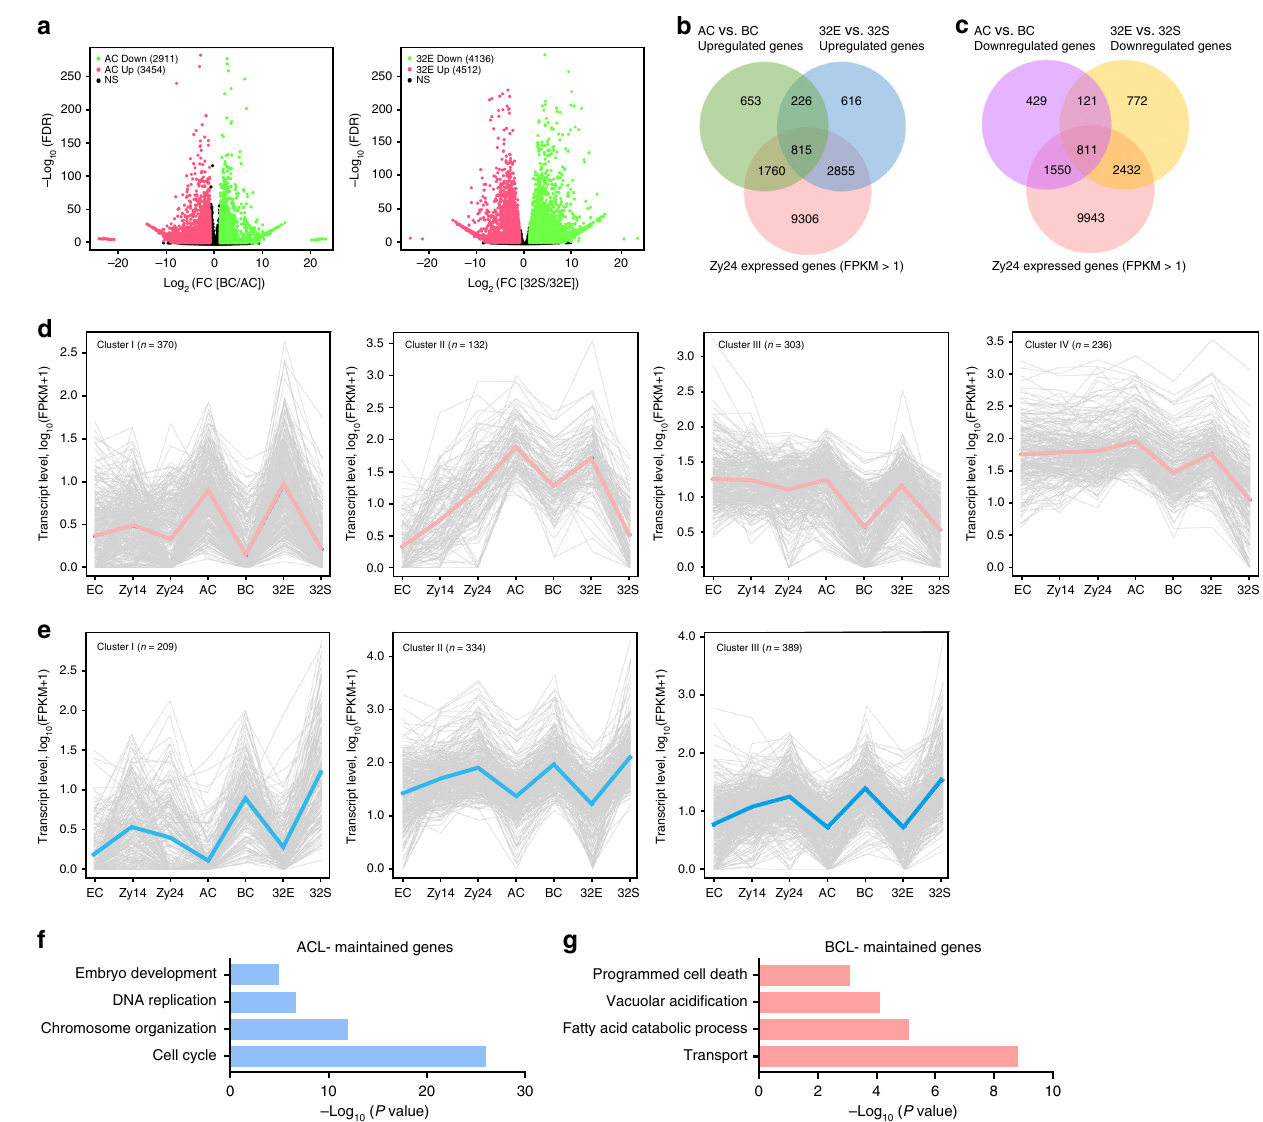
Fig. 3 Lineage speci fi c transcriptome analysis reveals progressive apical and basal cell lineage differentiation during early embryogenesis. a Volcano plots display differentially expressed genes between apical and basal cell lineages at 1-cell and 32-cell embryo stages. b , c Comparisons of upregulated genes ( b ) or downregulated genes ( c ) between AC/BC and 32E/32S. d , e Expression pro fi les of the apical cell lineage- ( d ) and basal cell lineage- maintained ( e ) genes in egg cells, zygotes, apical, and basal cell lineages of early proembryos. Pink lines ( d ) and blue lines ( e ) indicate the mean expression level of all genes in different groups. f , g GO enrichment analysis of apical cell lineage- ( f ) and basal cell lineage-maintained ( g ) genes, respectively. EC egg cell, Zy14 zygote at 14 h after